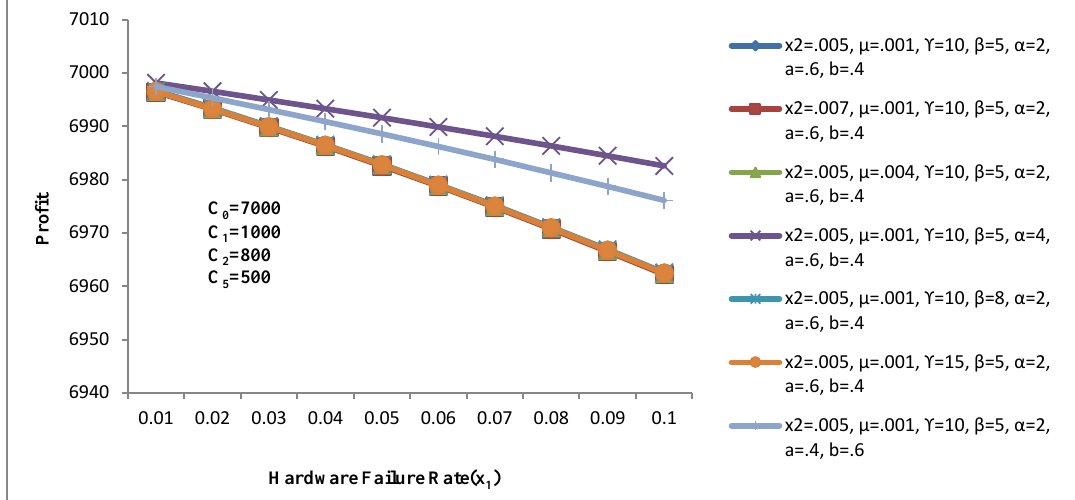
Figure 4. Profit (P 1 ) vs hardware failure rate ( 𝑥